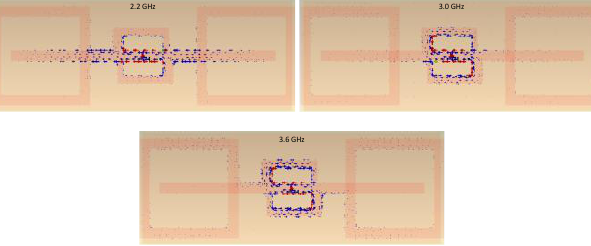
Figure 6: The surface current distributions over the antenna aperture at 2.2 GHz (top-left), 3.0 GHz (top-right) and 3.6 GHz (bottom).